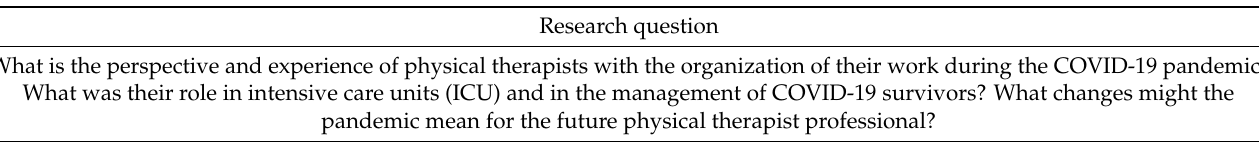
Table 4. Summary of methods and